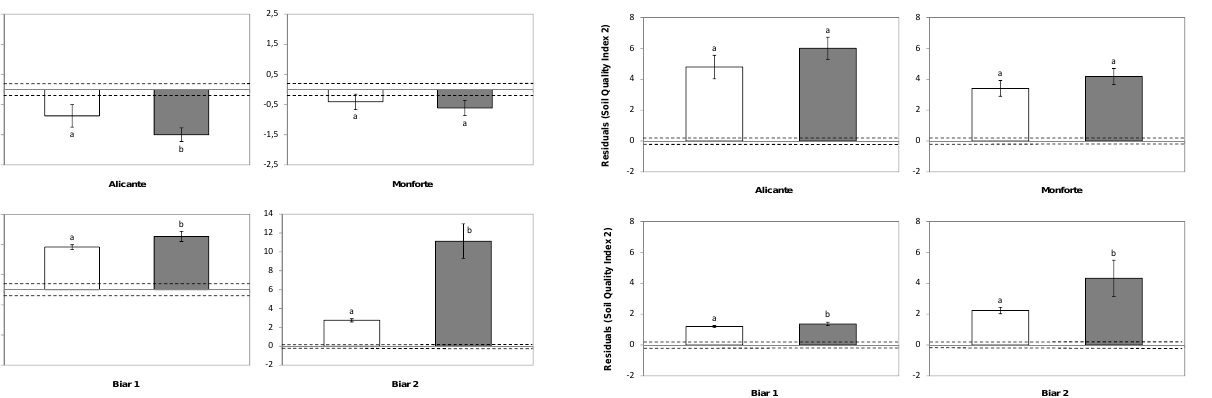
Fig. 3. Soil quality index 2 for each of the study sites. Dash lines limit 95% confidence interval of calibration (–0.23, + 0.23). Con- trols are indicated with white colour bars and irrigated with wastew- aters with dark grey colour. Different letters indicate significant dif- ferences between means at ( P< 0 . 05) after T-Student test. Error bars denote standard